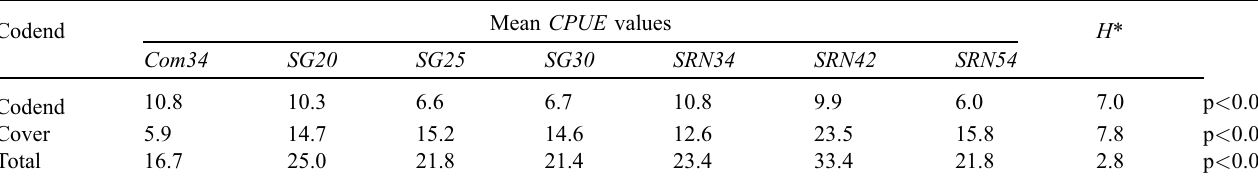
Table 1. Mean CPUE (g/fyke net/day) values of trial codends by compartments. Codend Mean CPUE values H* Com34